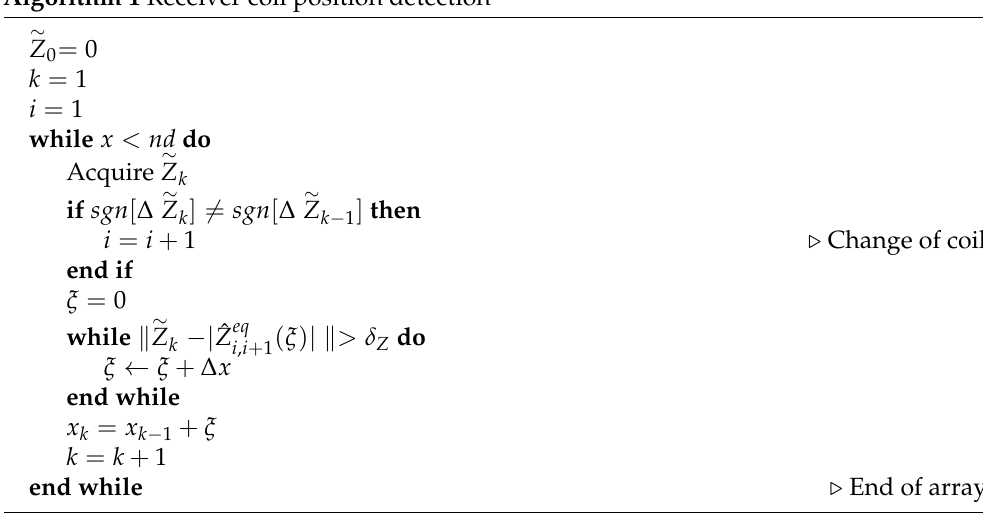
Algorithm 1 Receiver coil position